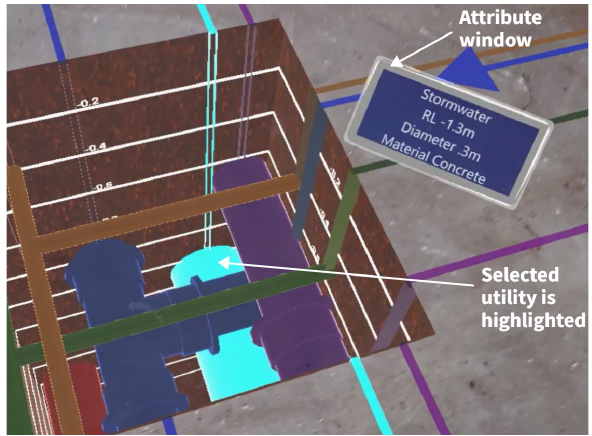
Figure 14 . Selected utility in "X-Ray Box View"